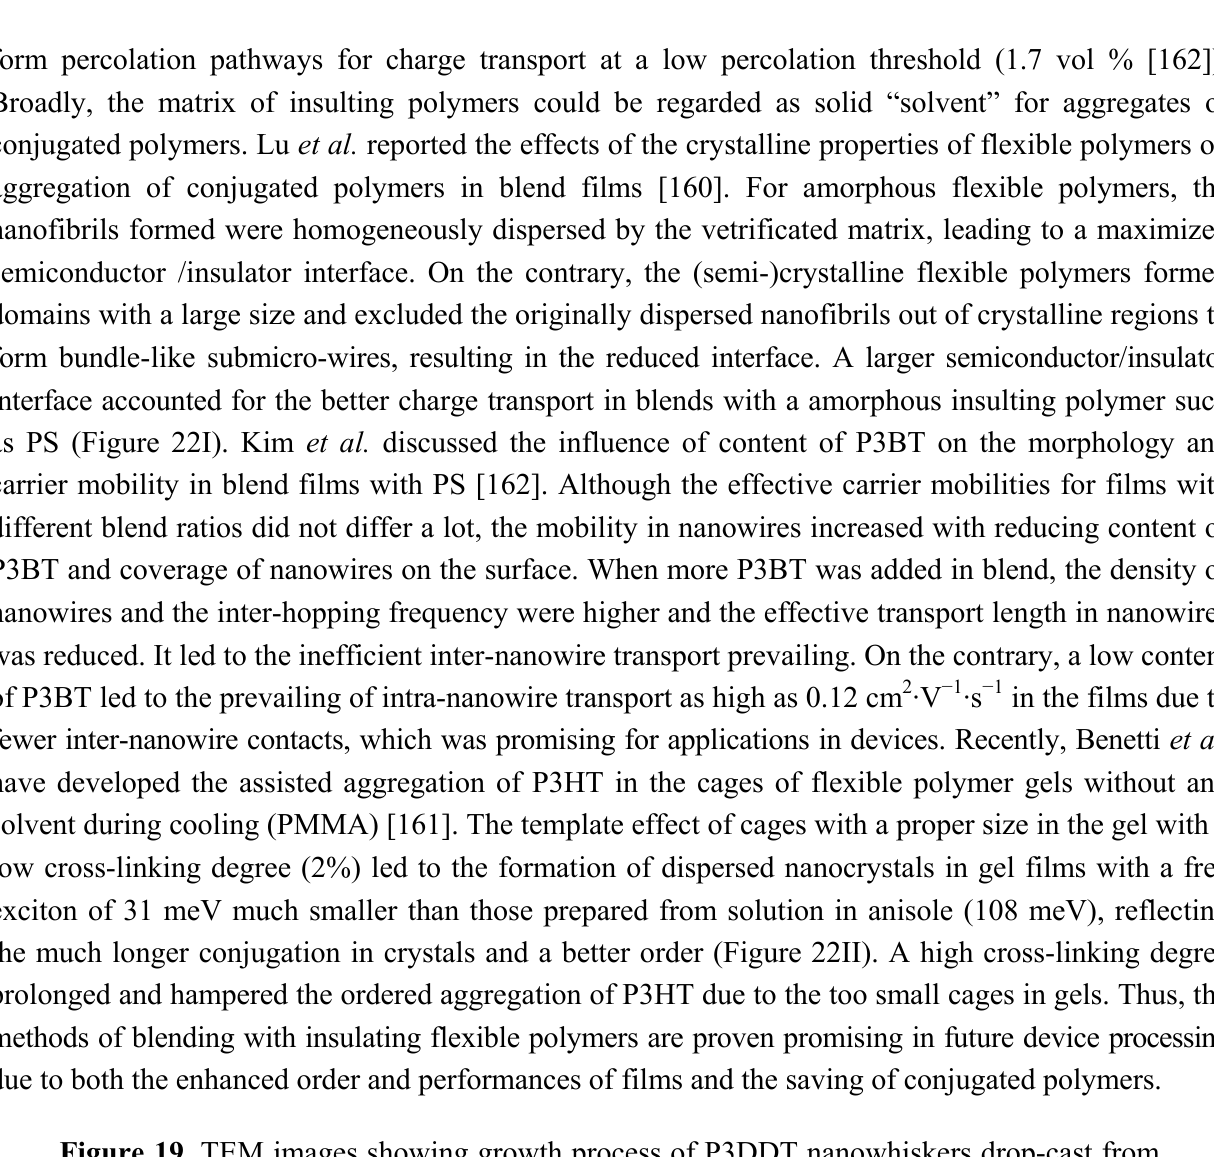
Figure 19. TEM images showing growth process of P3DDT nanowhiskers drop-cast from P3DDT/CB-anisole (1:4, 0.1 mg/mL) solution aged for different times, (Adapted with permission from [156]. Copyright 2011 American Chemical